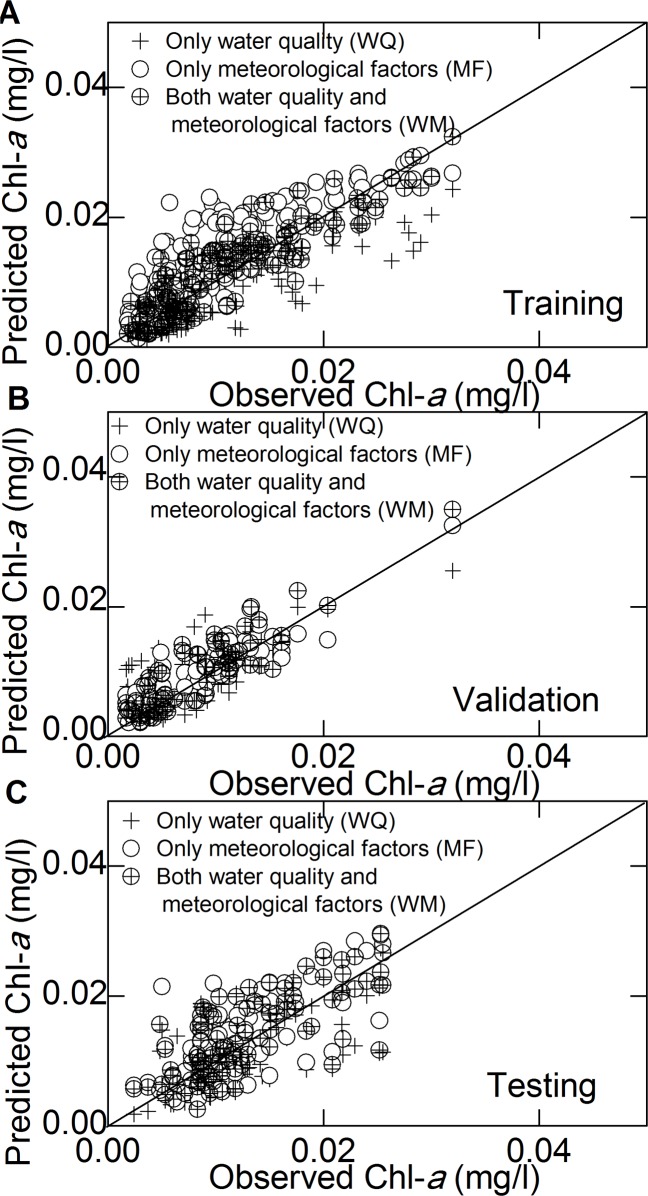
Scatter plots of the observed data vs. the model predictions using different inputs.(A) Chl-a prediction with different variables used as inputs for training; (B) is the same as (A) but for validation; (C) is the same as (A) but for testing.